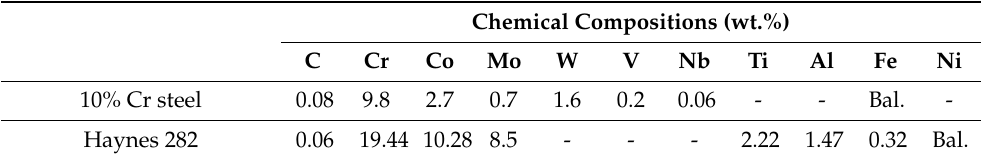
Table 1. Chemical composition of the 10% Cr steel BM and Haynes 282 filler